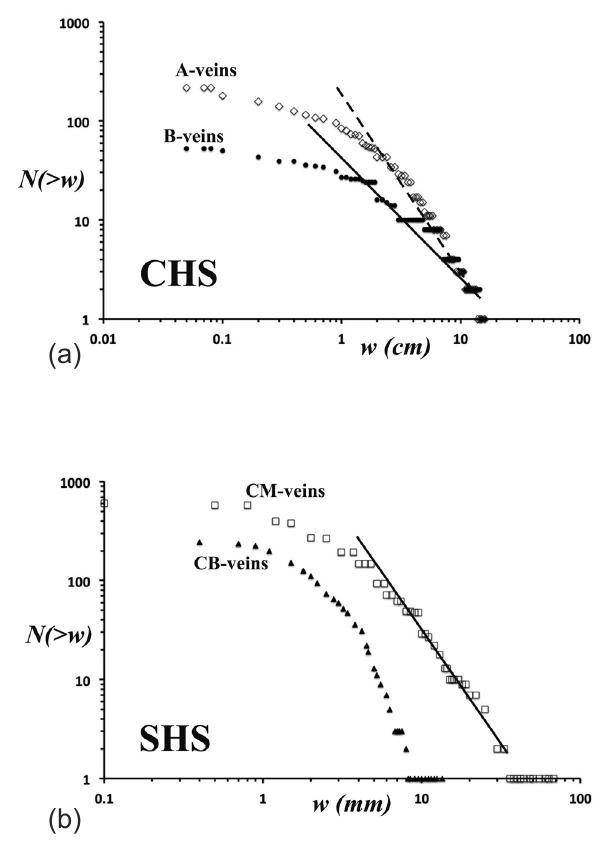
Figure 5. Log-log plots for the veins’ thickness distribution for the data sets in CHS and SHS (see also Table